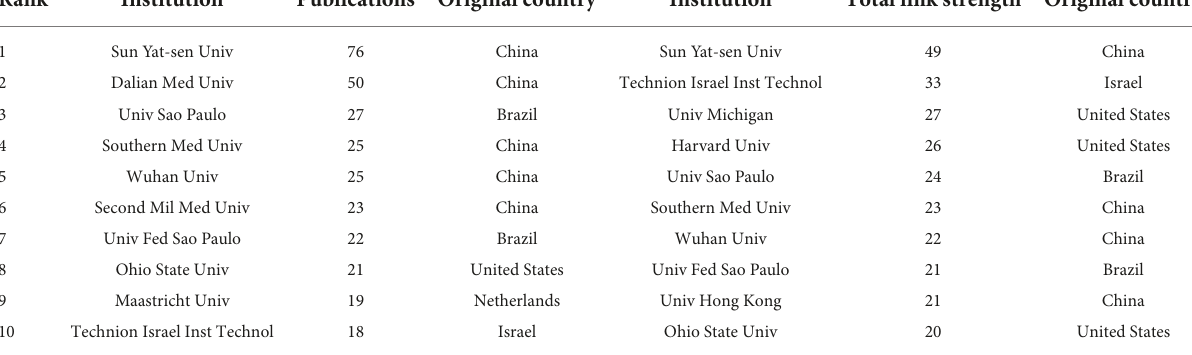
TABLE 2 Top 10 institutions in terms of number of articles issued and intensity of association. Rank Institution Publications Original